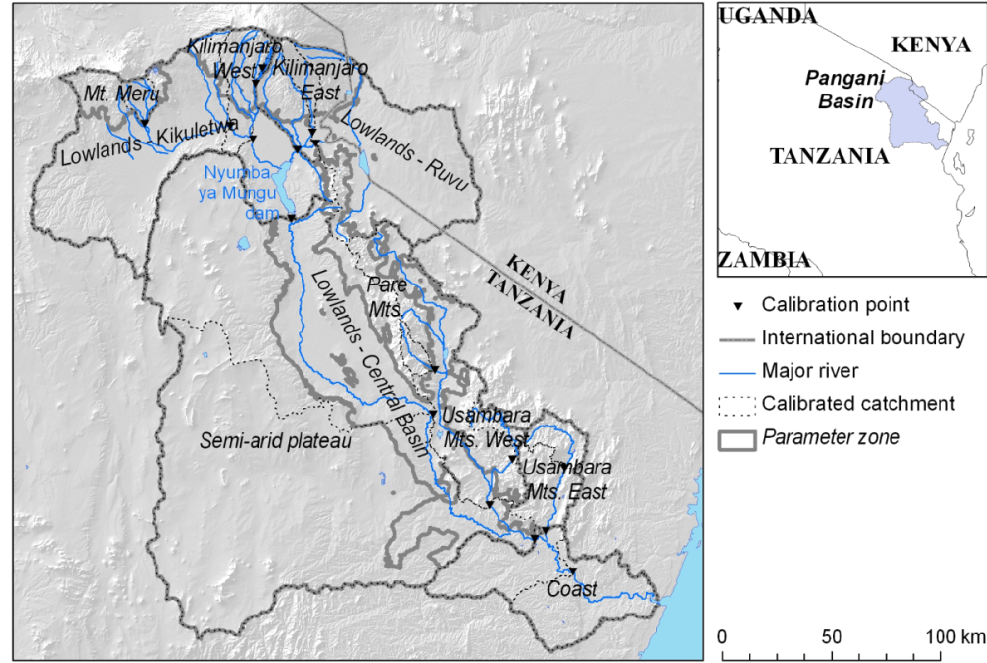
Fig. 1. Overview of the Pangani Basin with calibration points and parameter zones.